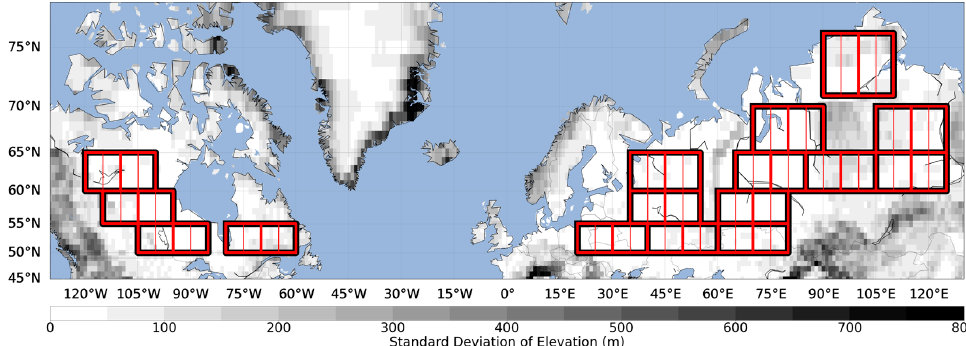
Figure 1. Sample cells used to compare ∆ SWE estimates from Cloudsat and B4. Black-bordered boxes represent to 20 ◦ × 5 ◦ cells, and red borders within black-bordered boxes represent 10 ◦ × 5 ◦ and 5 ◦ × 5 ◦ cells.